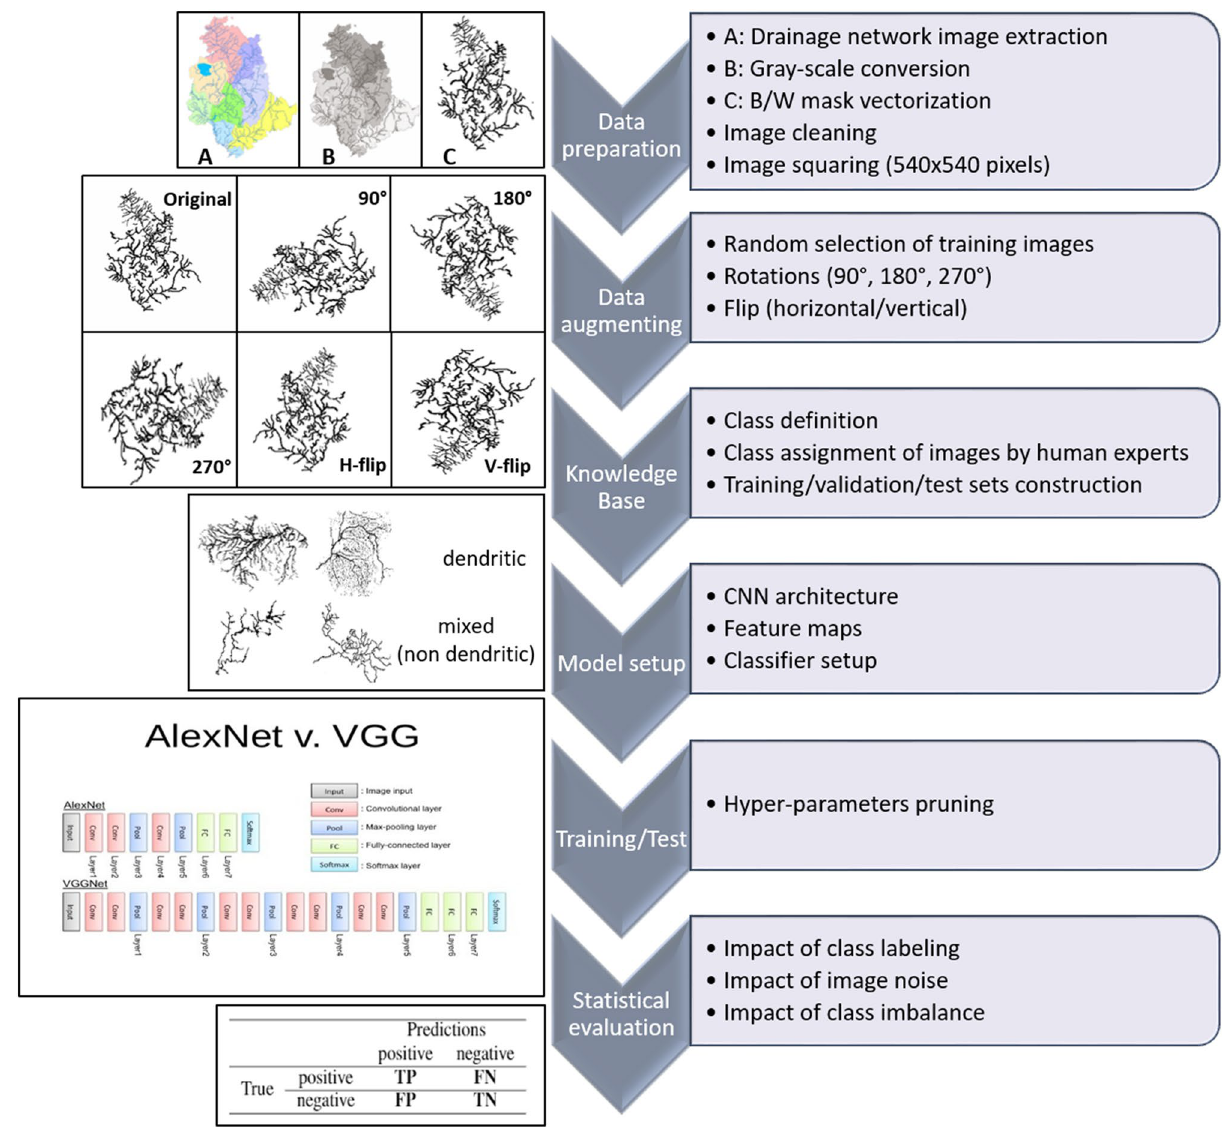
Figure 2. Flowchart of drainage network data processing. On the left, the AlexNet and VGGNet picture, taken from 54 . The bottom left panel shows an example of a confusion matrix for a two-class problem: the rows refer to the expected values, while the columns to the classifier output. TP and TN, True Positive and True Negative, respectively, are the two class quantities of samples correctly classified. FP and FN indicate, respectively, the quantities of False Positives and False